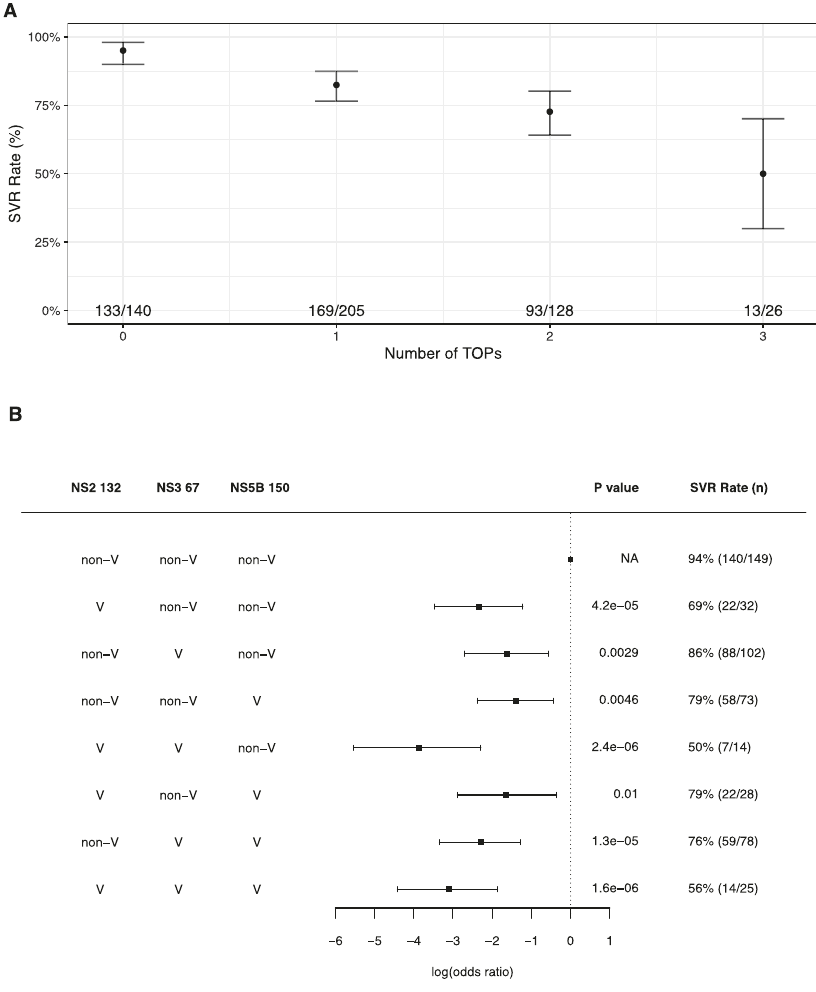
Fig. 2 Covariation of treatment outcome polymorphisms (TOPs) and their impact on sustained virological response (SVR) rate. A SVR rate for patients with different numbers of TOPs in baseline sequences. The dots indicate the SVR rate in each group and the lines indicate its 95% con fi dence intervals. The numbers in each group are shown at the bottom of the fi gure. B Covariation between the three novel TOPs and their association with treatment outcome. Combinations tested are listed in the table on the left. The squares show the estimated effect size (log(odds ratio)) for each group and the lines show its 95% con fi dence interval estimated from logistic regression. The P -value (logistic regression) and the SVR rate for each group are shown on the